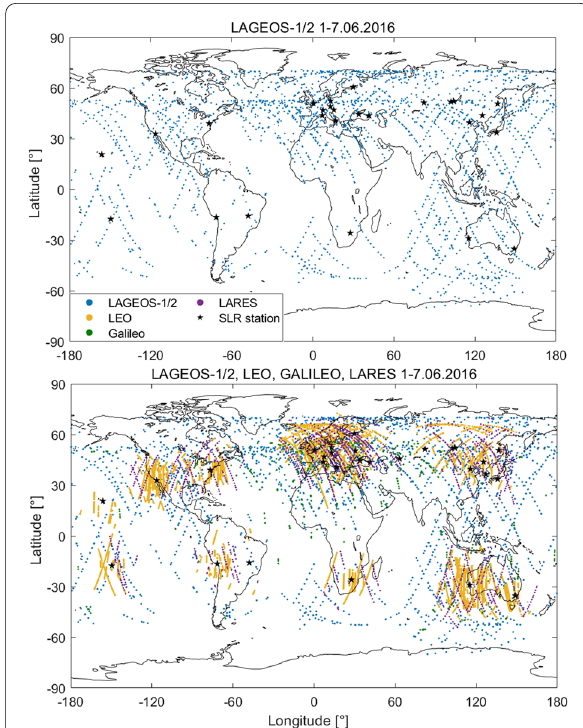
Fig. 3 Global distribution of SLR NPs collected by SLR stations for LAGEOS-1/2 satellites (top) and LAGEOS-1/2, LEO, Galileo, LARES satellites (bottom) from the period of June 1–7,